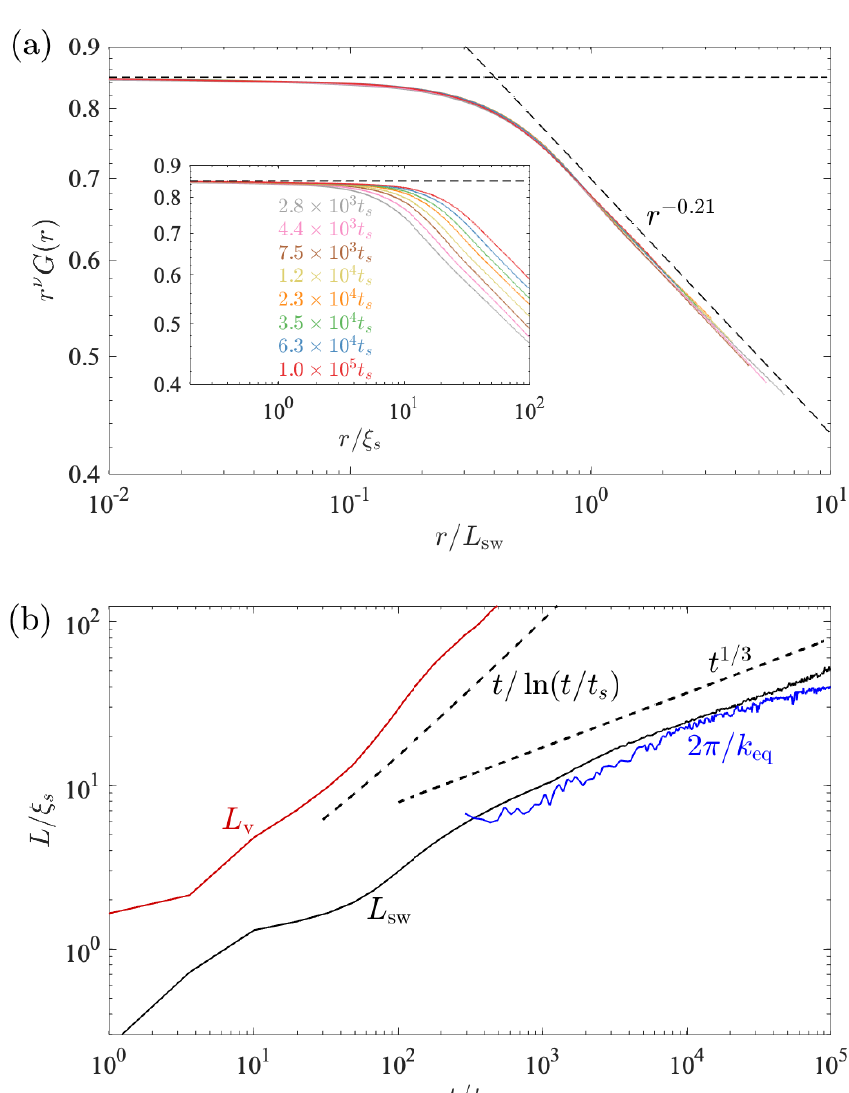
Figure 3: (a) The evolving spatial correlations of transverse spin after all vortices have annihilated (inset) collapse onto a single curve (main figure) according to Eq. (12) ( t ) . The nonequilibrium (decaying) when rescaled by the growing length scale L sw portion of r ν G ( r ) shows a r − 0.21 algebraic decay that indicates a nonequilibrium tem- perature of T ≈ 0.9 T . The flat dashed line indicates equilibrium correlations. (b) BKT ( t ) grows as t 1 / 3 for t > 10 3 t ) The length scale L , much slower than the t / ln ( t / t s s sw ( t ) . The largest thermarlised wavelength growth of average intervortex spacing L v ( k , t ) is 2 π k ( t ) − 1 , which follows the growth of L ( t ) extracted from ε c eq sw